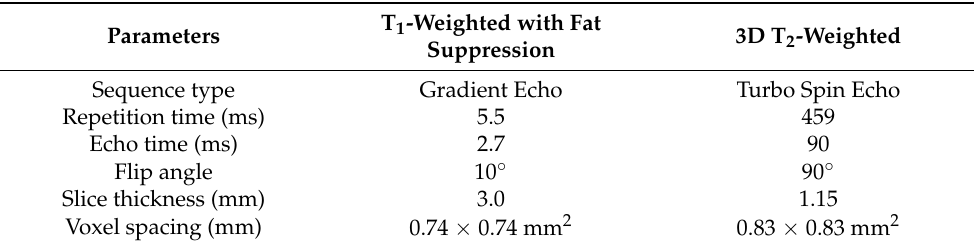
Table 1. MRI imaging